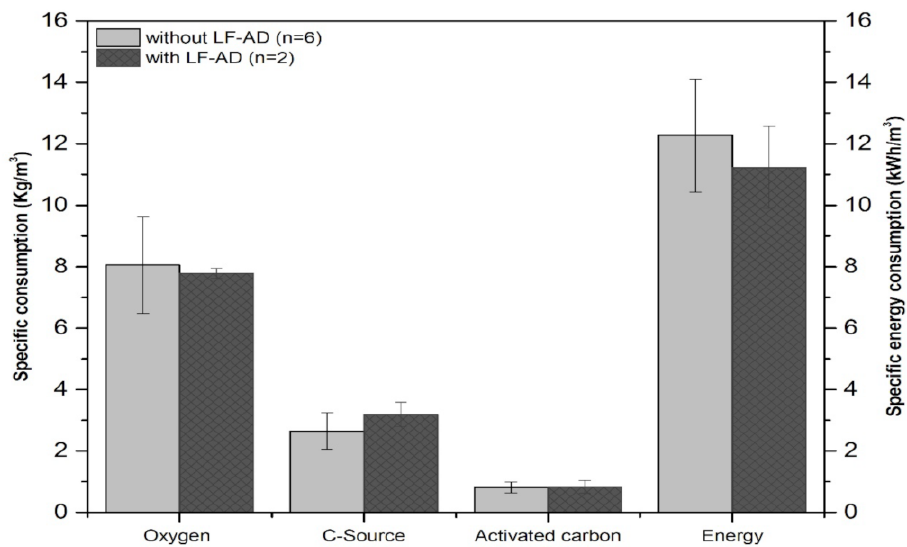
Figure 11. Annual operational resource consumption before and during the combined treatment of LL and the